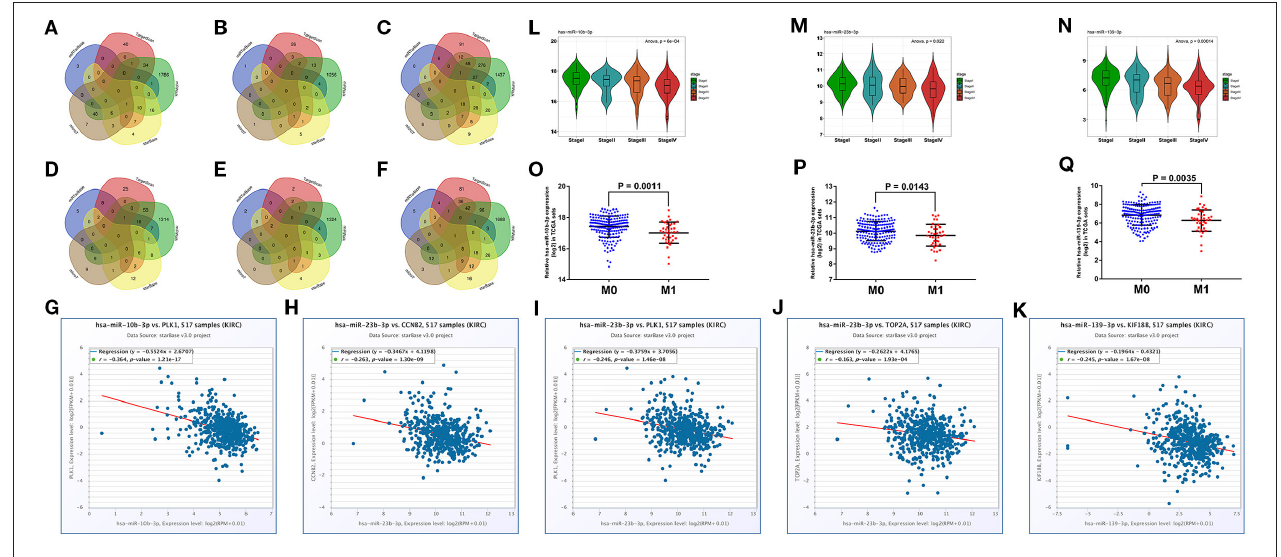
FIGURE 6 | Prediction and screening of upstream potential miRNAs for six hub mRNAs. Venn diagram of target miRNAs for BUB1B (A) , CCNB2 (B) , KIF18B (C) , PLK1 (D) , PTTG1 (E) , and TOP2A (F) . (G) The expression correlation between hsa-miR-10b-3p and PLK1 in ccRCC. (H) The expression correlation between hsa-miR-23b-3p and CCNB2 in ccRCC. (I) The expression correlation between hsa-miR-23b-3p and PLK1 in ccRCC. (J) The expression correlation between hsa-miR-23b-3p and TOP2A in ccRCC. (K) The expression correlation between hsa-miR-139-3p and KIF18B in ccRCC. Expression analyses of hsa-miR-10b-3p (L) , hsa-miR-23b-3p (M) , hsa-miR-139-3p (N) among different stages. Expression pattern of hsa-miR-10b-3p (O) , hsa-miR-23b-3p (P) , hsa-miR-139-3p (Q) between distant metastasis samples (M1) and non-distant metastasis samples (M0). The value of p < 0.05 was considered statistically